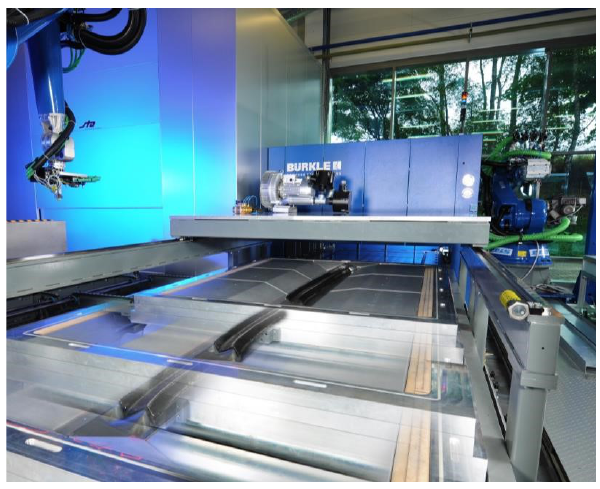
Figure 5: Hot forming.